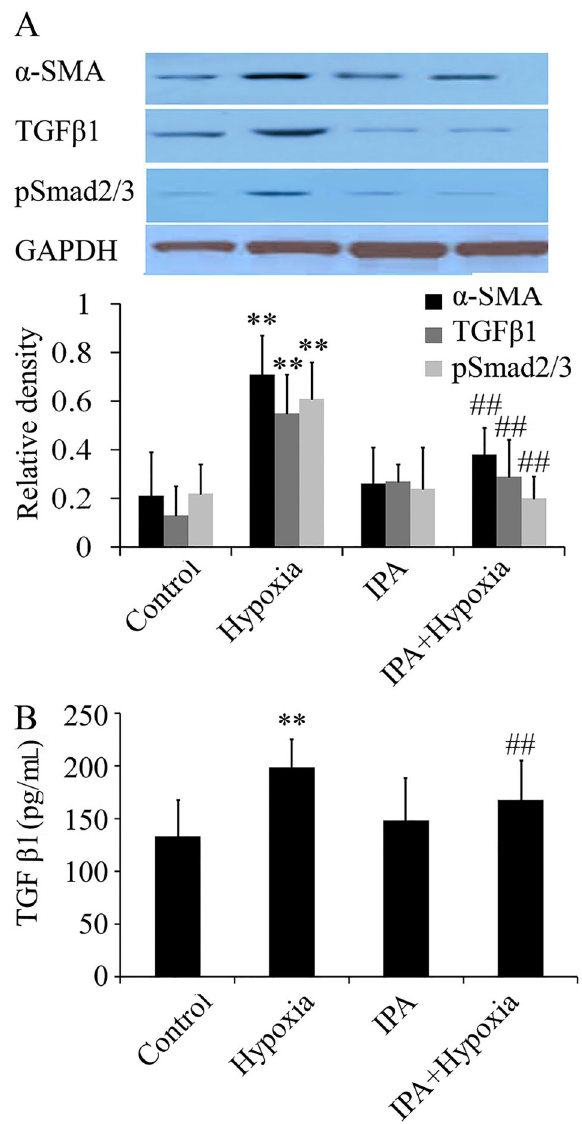
Figure 4. Effects of inactivated P. aeruginosa (IPA) on TGF- b 1 signaling and a -SMA protein expression, assayed by western blot ( A ) and levels of TGF- b 1 in supernatant, assayed by ELISA ( B ) (n=6) in rats. Hypoxia increased TGF- b 1/Smad signaling and a -SMA protein expression at 24 h, and IPA inhibited the expres- sion of TGF- b 1/Smad signaling and a -SMA induced by hypoxia. Moreover, the production of TGF- b 1was up-regulated in the hypoxia group and IPA inhibited the production of TGF- b 1. **P o 0.01 vs control; ## P o 0.01 vs hypoxia